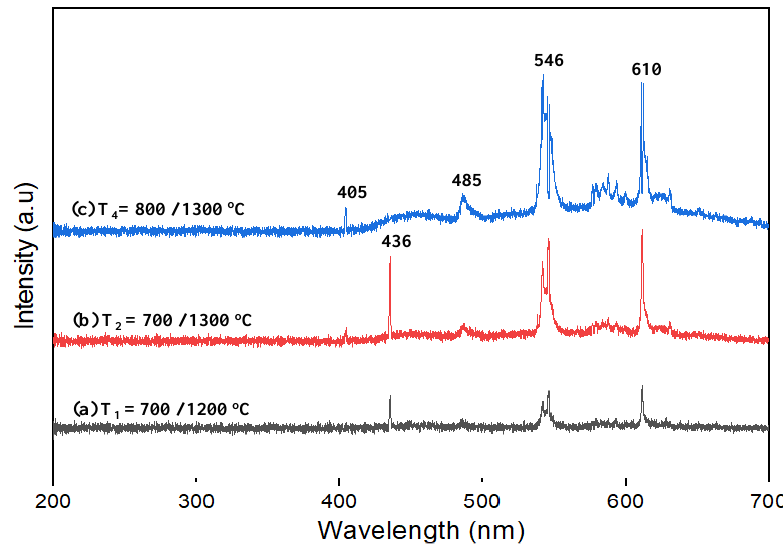
Figure 6. Cathodoluminescence spectra: h-BN quantum dots grown at different K-cell temperatures for samples T 1 (700/1200 °C) and T 2 (700/1300 °C), and at different substrate temperatures for samples T 2 (700/1300 °C) and T 4. (800/1300 °C).